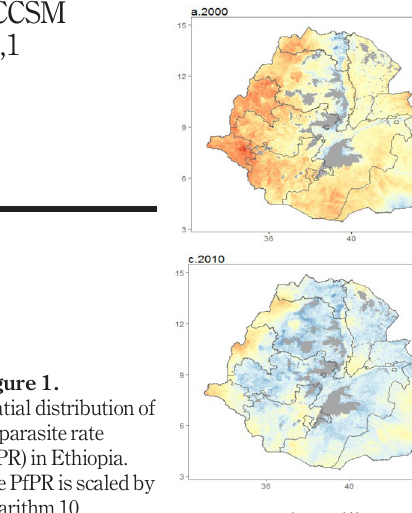
Figure 1. Spatial distribution of P.f parasite rate (PfPR) in Ethiopia. The PfPR is scaled by logarithm